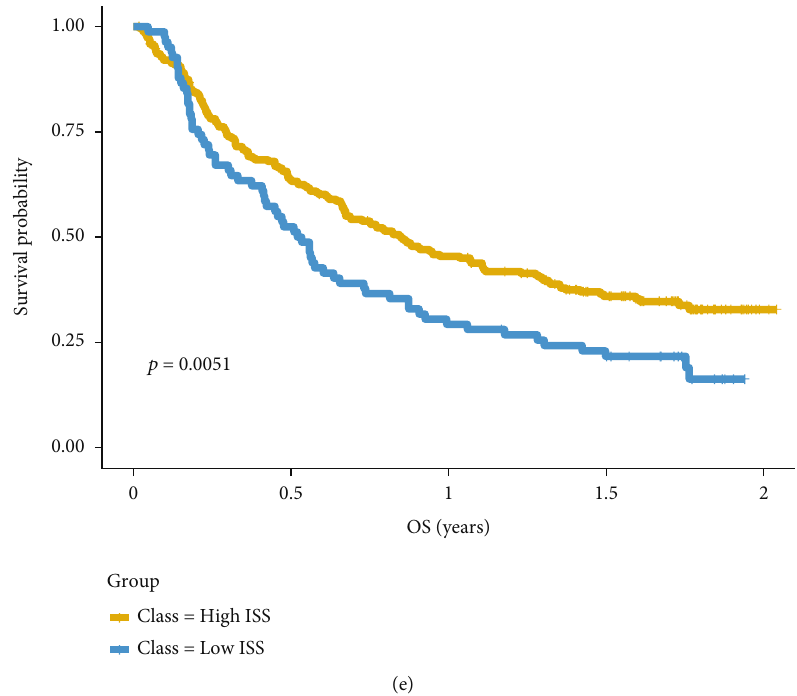
Figure 6: ISS as a predictor of tumor immune status and immunotherapy responsiveness: (a) correlation between the ISS and ISS component genes and tumor mutation burden and immune features; (b) comparison of ISS between di ff erent immune cell groups; (c) comparison of ISS between di ff erent immune subtypes; (d) comparison of immunotherapy responsiveness between the high- and low-ISS groups; (e) comparison of patient prognosis between the high- and low-ISS